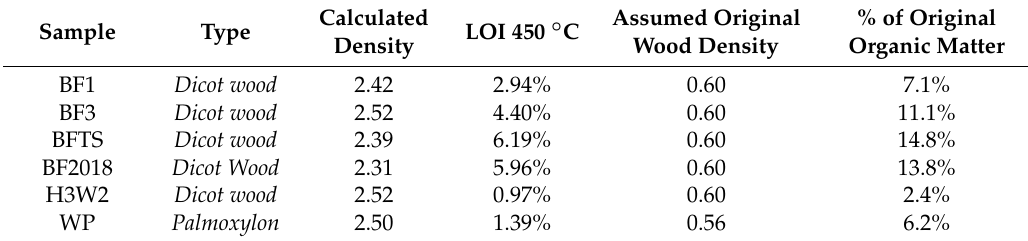
Table 2. Relict organic matter.